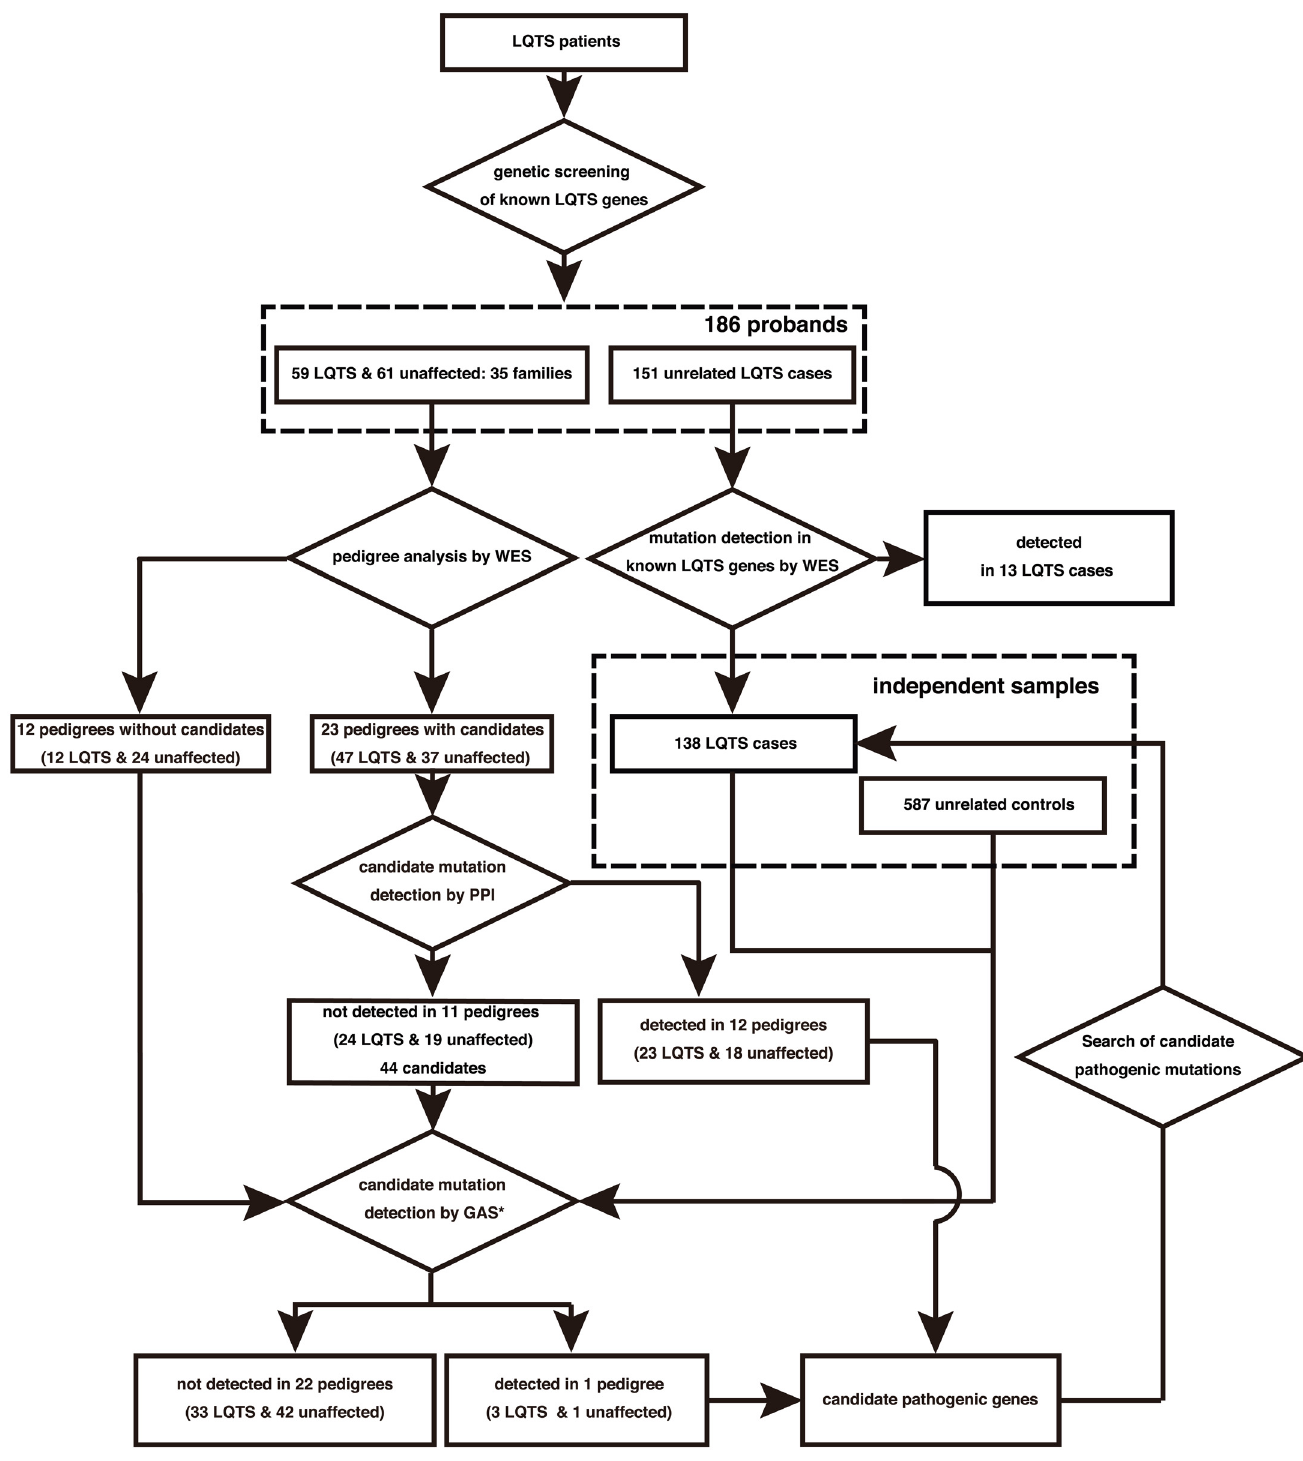
Fig 3. Experimental work flow for detecting candidate pathogenic mutations.